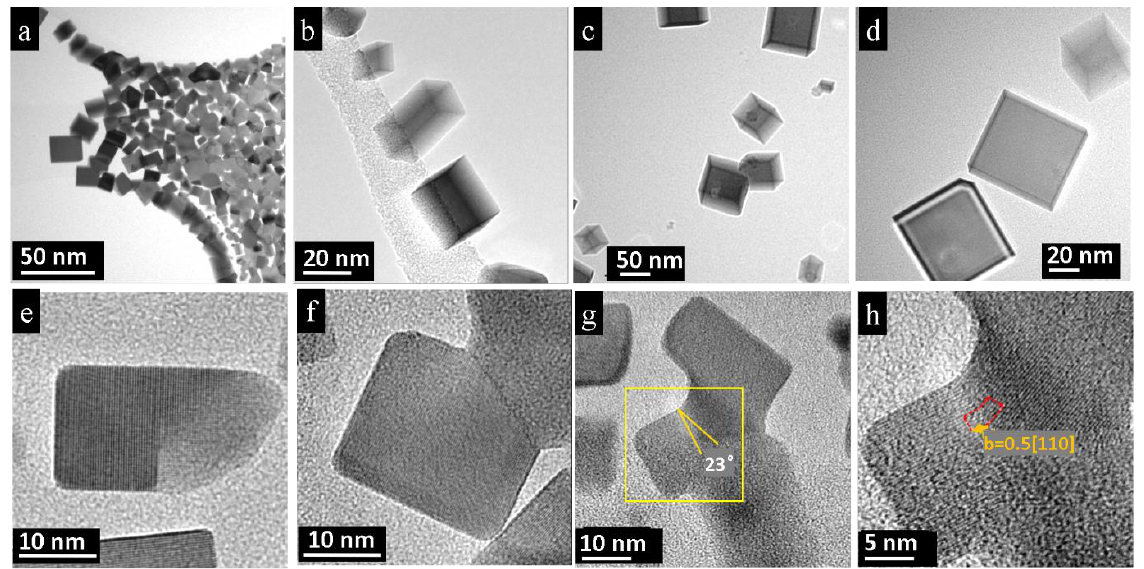
Figure 3. Electron-beam treatment products of the PbTe single crystal: ( a ) Overview of interconnected PbTe nano-bars. Near the initial crystal, a large amount and high density of cubes and bars occur, which form a 2D layer. ( b – d ) At larger distances away from the initial aggregate, the number of nanoparticles drops; thus, individual and well-separated nano-bars with different orientations and aspect ratios can be observed. ( e ) HRTEM image of a partially formed nano-bar. ( f ) Neighboring nano-bars with imperfect attachment. ( g , h ) Fused cubes with edge dislocation, Burgers vector b = a /2 ⟨ 110 ⟩ .